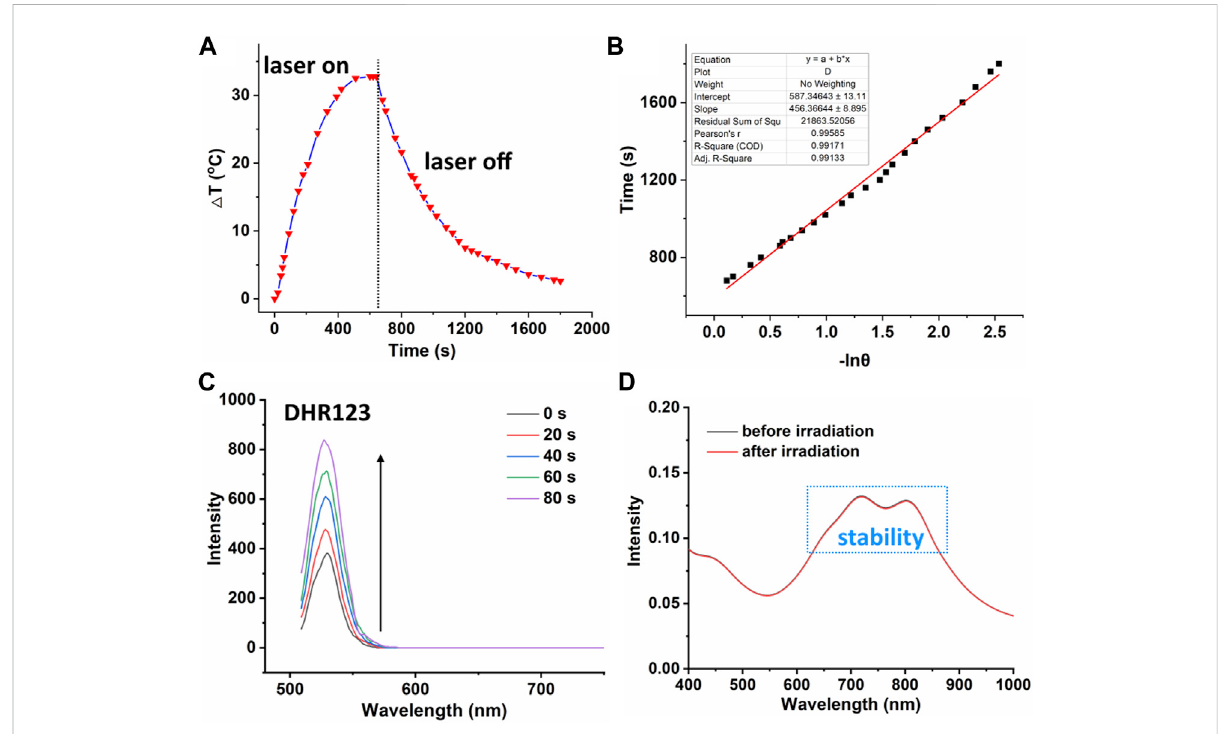
FIGURE 2 (A) Temperature elevation and decrease curve of PDPP NPs (730 nm, 500 W/cm 2 , 10 min). (B) Linear fi tting of − ln θ versus time. (C) Fluorescence intensity of DHR123 with laser irradiation (730 nm, 50 W/cm 2 ). (D) Absorbance spectra of PDPP NPs before and after